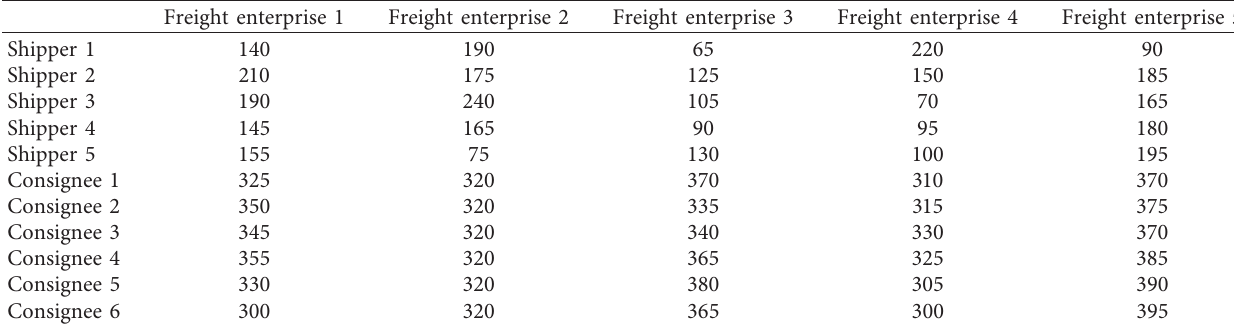
Table 10: The distance between nodes in the large bulk cargo transport network